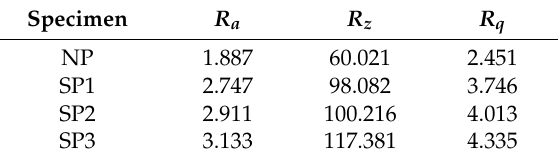
Table 4. Surface roughness of notched specimens.